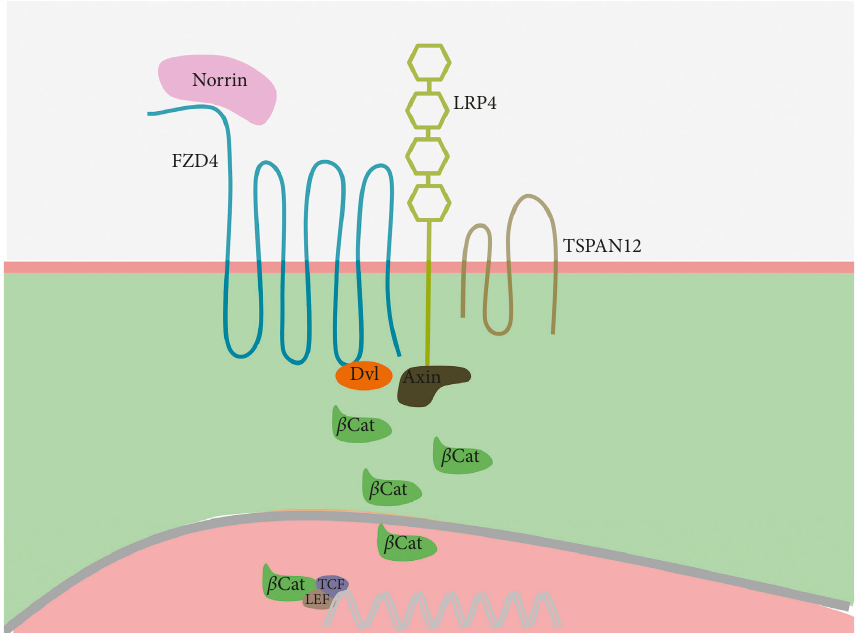
Figure 1: A schematic of the Norrin/ β -catenin signal pathway. When Norrin was bond to the receptor complex FZD4/LRP5/TSPAN12, Dishevelled and Axin would be recruited to FZD5 and LRP5. Consequently, β -catenin escaped from the degradation complex and entered nucleus to initiate gene transcription collaborated with T-cell factor/lymphoid-enhancing